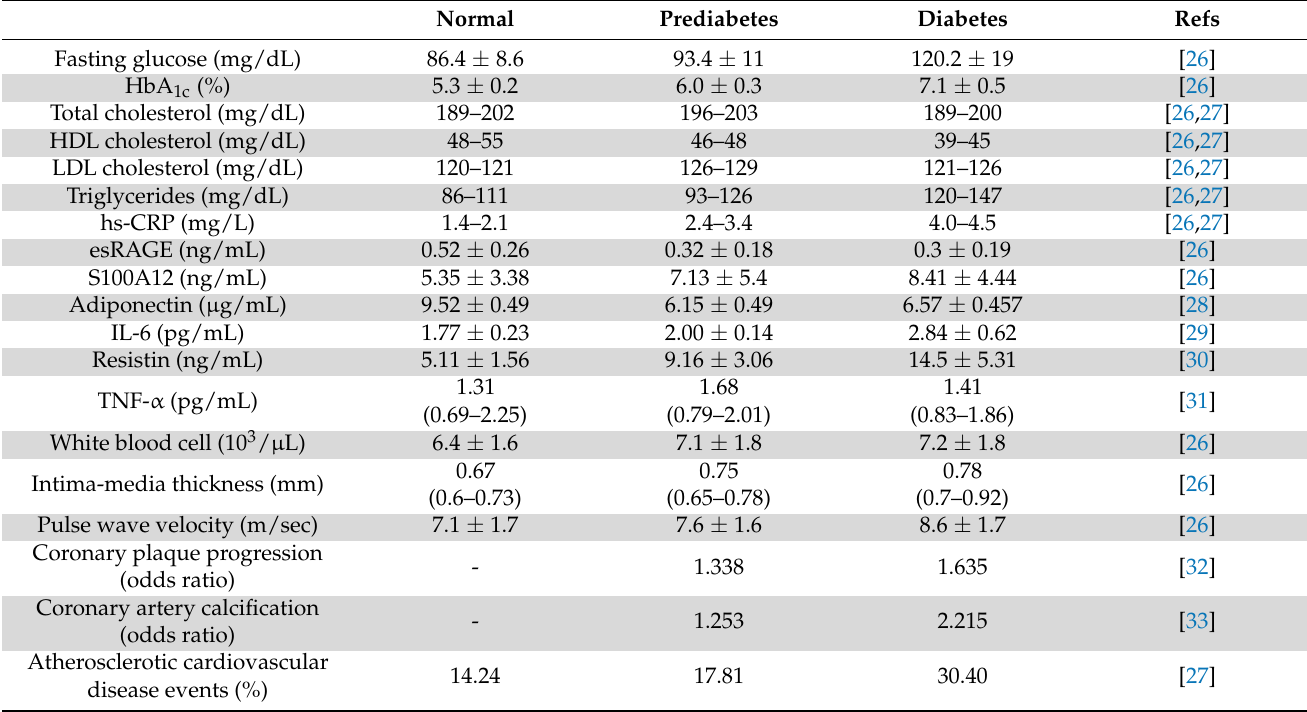
Table 1. Comparison of the factors contribute to atherogenesis between prediabetes and diabetes. Normal Prediabetes Diabetes